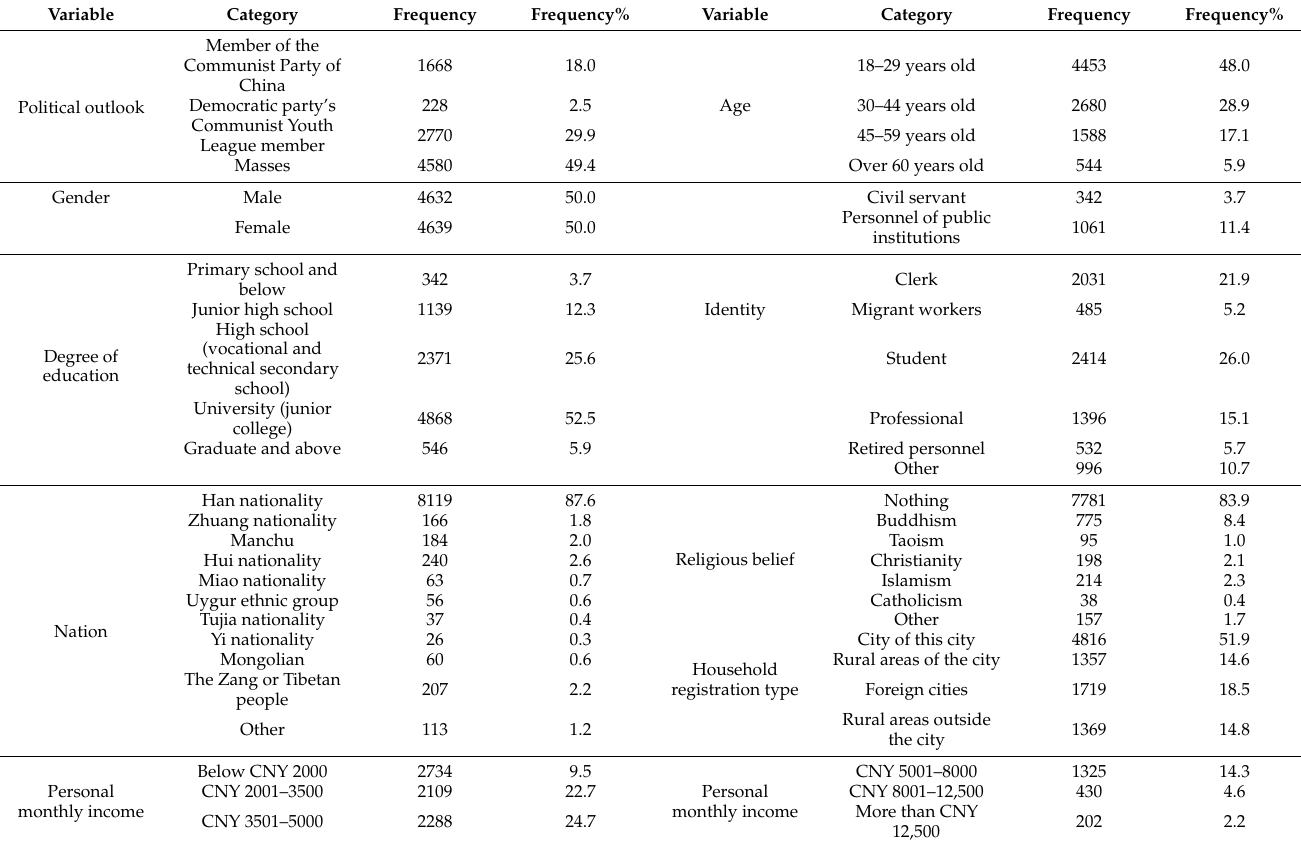
Table 1. Statistical table of residents’ basic information filled in the questionnaire.